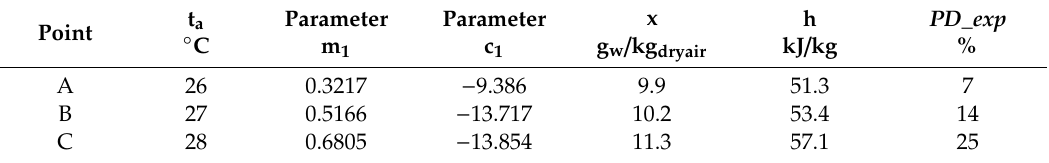
Table 6. The estimated humid air enthalpy points A, B and C calculated with Equation (13) (at three fixed temperatures, see Figure 7) set the boundaries of the non-binding Fanger equation zone for human thermal comfort assessment under the following assumptions: air speed < 0.1 m / s, 0.6 clo, 1.1 met and t a = t mr